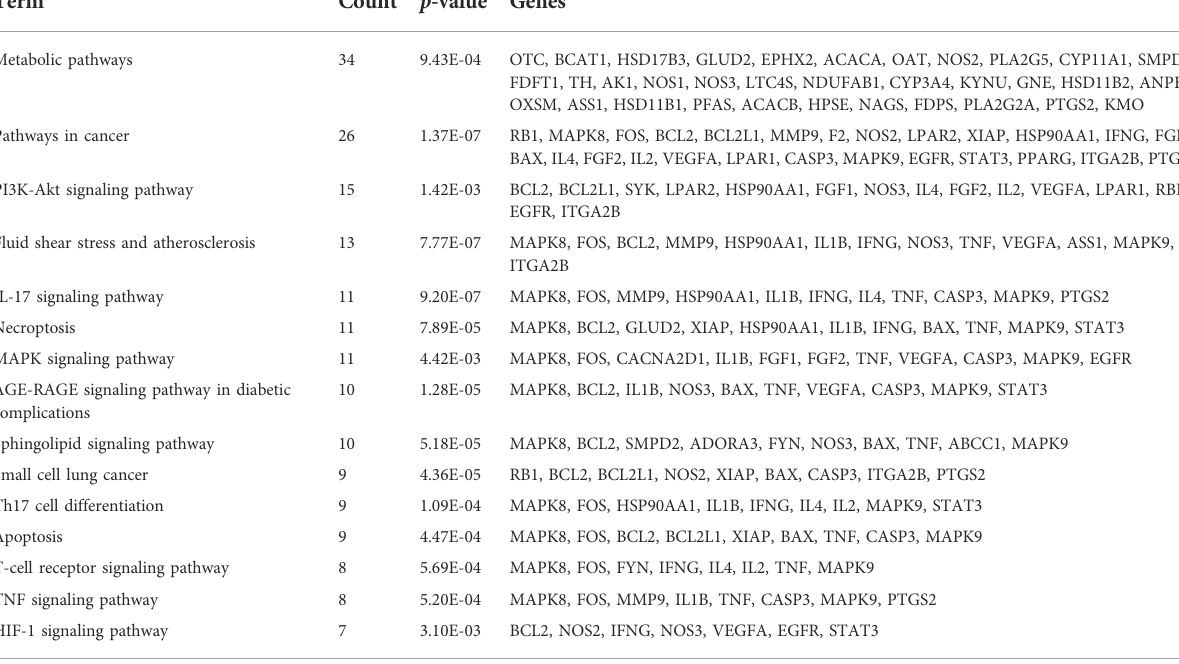
TABLE 2 Top 15 pathways for Kyoto Encyclopedia of Genes and Genomes analysis.